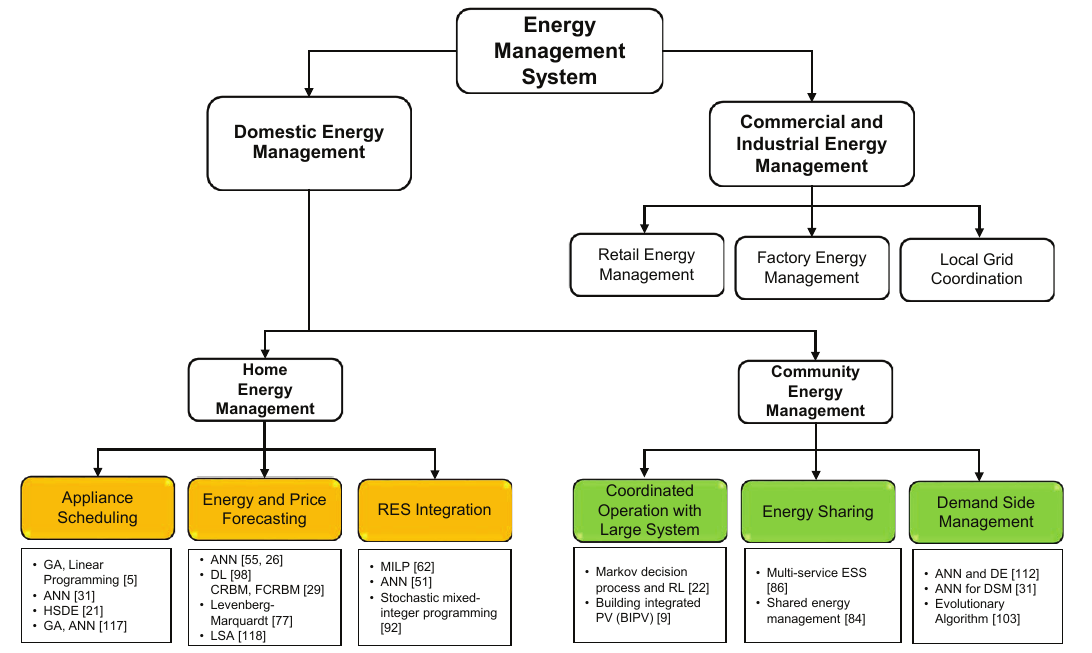
Figure 3. Energy management system in the SG